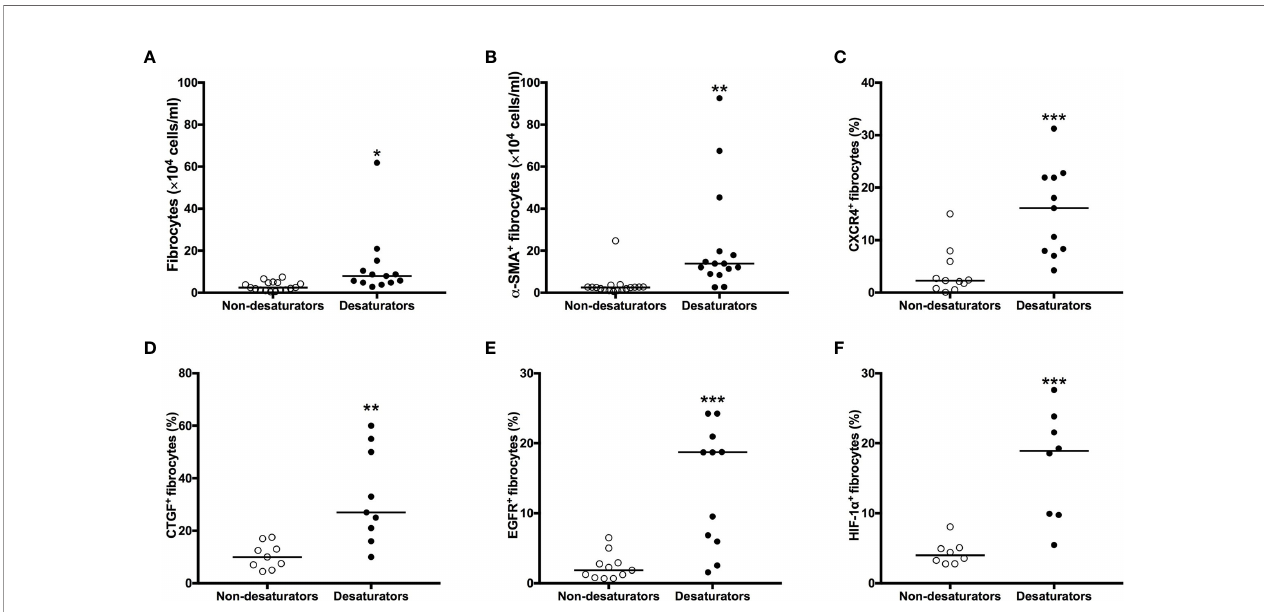
FIGURE 5 | Higher CXCR4, CTGF, EGFR and HIF-1 a expression with greater increased in number and myo fi broblastic differentiation in fi brocytes from COPD desaturators. The number of Col I + /CD45 + fi brocytes (A) and differentiating a -SMA + fi brocytes (B) in NANT cells were determined by fl ow cytometry after 14 days in culture. NANT cells were isolated from COPD non-desaturators and desaturators. The proportion of CXCR4- (C) , CTGF- (D) , EGFR- (E) and HIF-1 a - (F) expressing fi brocytes within freshly isolated NANT cells from desaturators, determined by fl ow cytometry, was higher compared to that from non-desaturators. Horizontal lines represent the median values for each group. The differences between disease groups were determined by Mann-Whitney test. * P < 0.05, ** P < 0.01, *** P < 0.001. CXCR4, CXC chemokine receptor 4; CTGF, connective tissue growth factor; EGFR, epidermal growth factor receptor; HIF-1 a , hypoxia-inducible factor-1 a ; COPD, chronic obstructive pulmonary disease; NANT cells, non-adherent non-T fraction of peripheral blood mononuclear cells; a -SMA, a -smooth muscle actin.